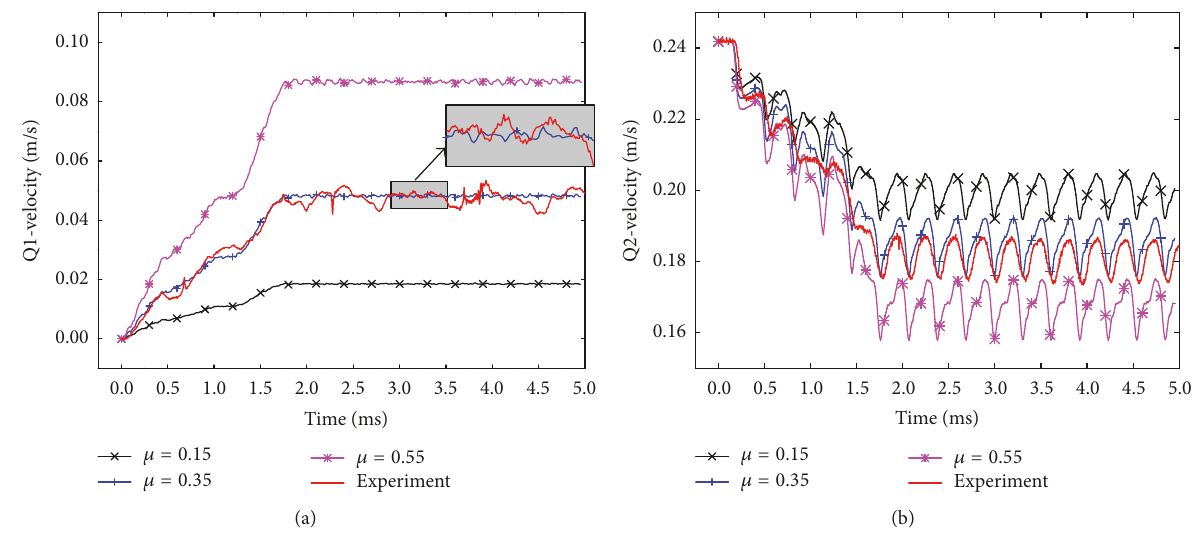
Figure 12: Comparisons between simulations using different friction coefficients and experiment: (a) velocity of point Q1; (b) velocity of point